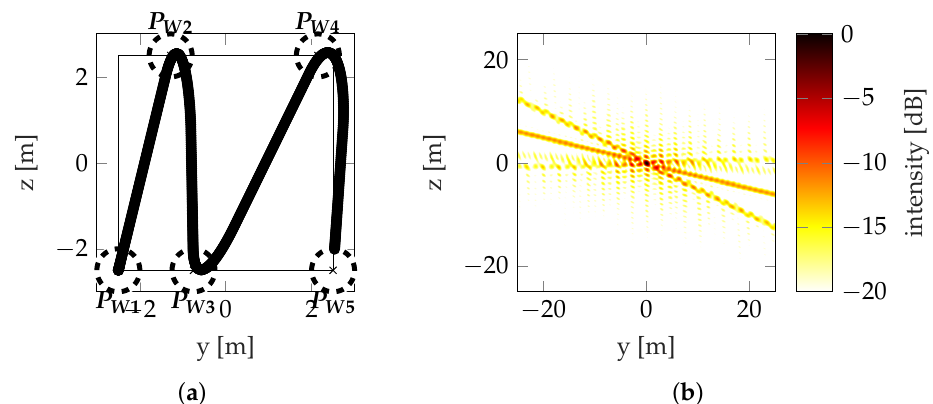
Figure 8. Real trajectory example: ( a ) Trajectory with waypoints denoted by P W and the acceptance circles marked with a dotted line. ( b ) PSF.